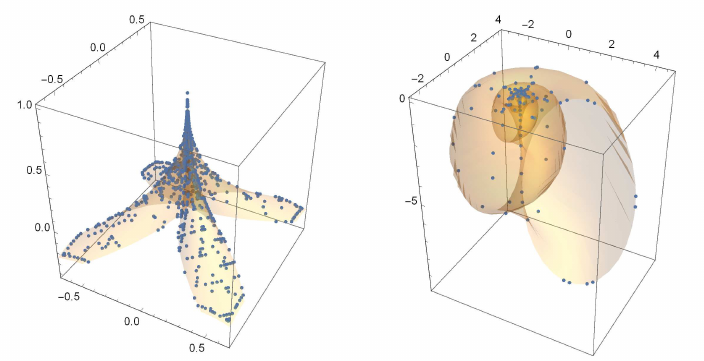
Fig. 7 The points where the unit normal is approximated better for φ 1 ( t , s ) and φ 2 ( t , s )